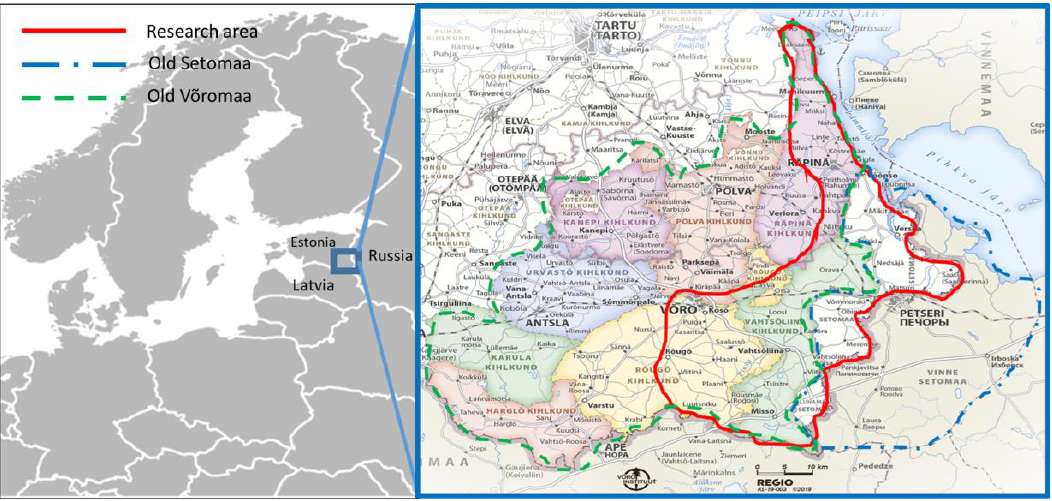
Figure 1. Research area: the approximate area is encircled by a red line. On the right are the administrative boundaries of historical Võromaa and Setomaa, in which place names are written in the Võro dialect (Source: Võro Instituut).